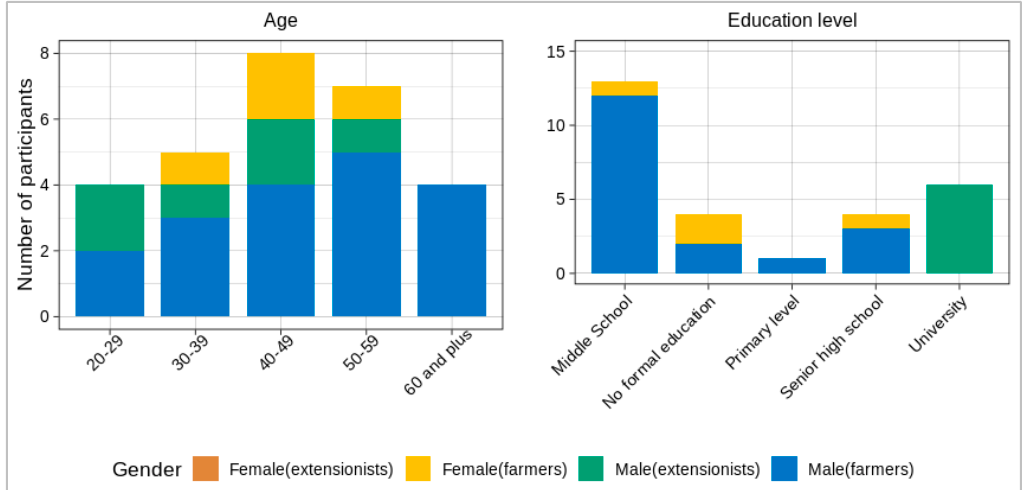
Figure 3. Age, education level, and gender of farmers and extension agents participating in Figure3. Age, educationlevel, andgenderoffarmersandextensionagentsparticipatingincoproduction coproduction experiment for weather and climate information in Ada East District, Ghana. experiment for weather and climate information in Ada East District, Ghana.